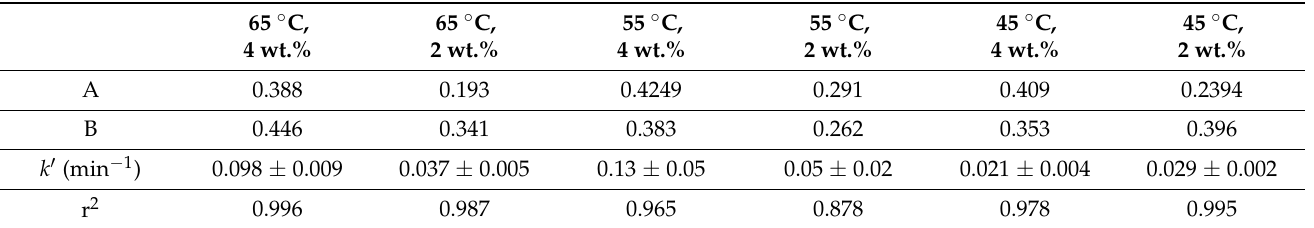
Table 4. Parameters obtained for the modified pseudo-first-order reaction in the homogeneous esterification at different temperatures and acid